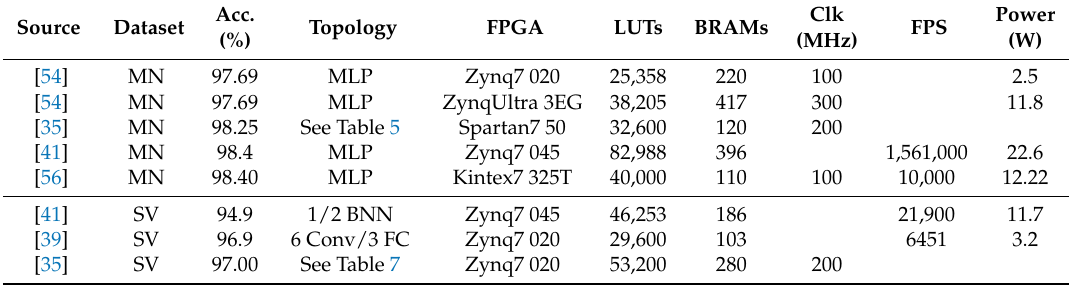
Table 12. Comparison of FPGA implementations. The accuracies reported from [68,70] were